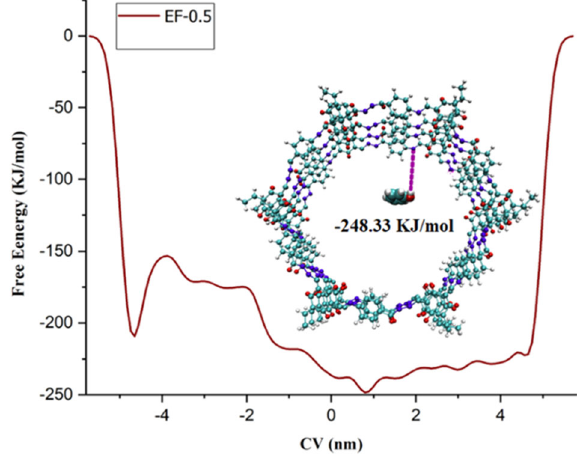
Fig. 5 The free energy pro fi le with imposing an electrical fi eld at 0.5 V nm − 1 . Water molecules are not shown for